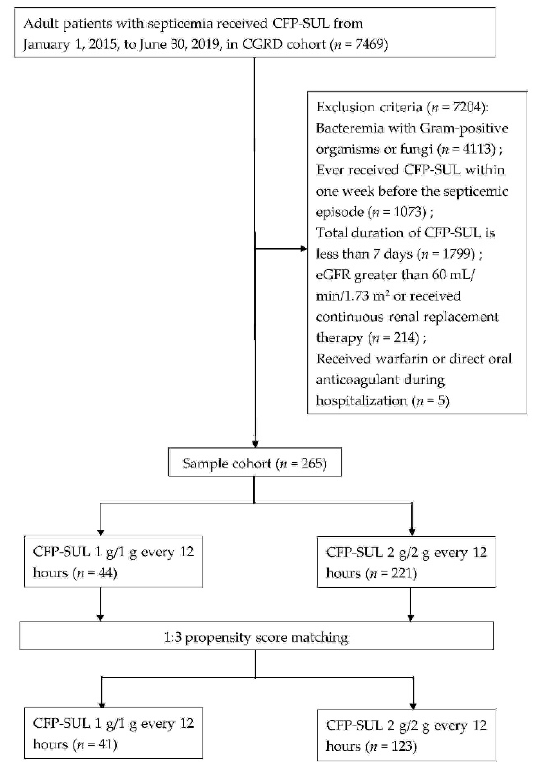
Figure 1. Flow chart of patient selection. Table 1. Clinical characteristics of CGRD cohort before and after propensity score matching (PSM).